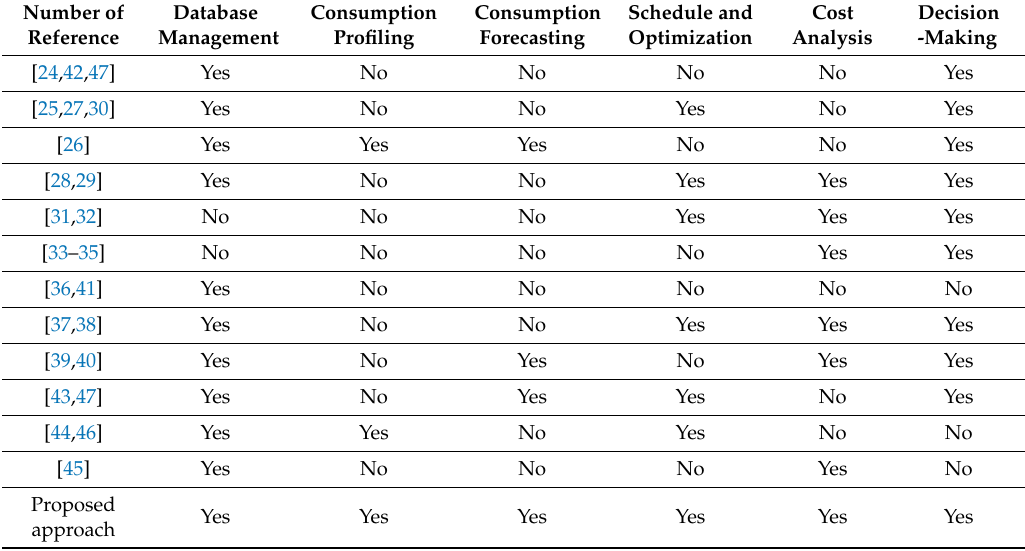
Table 2. Comparison between proposed approach and the literature.